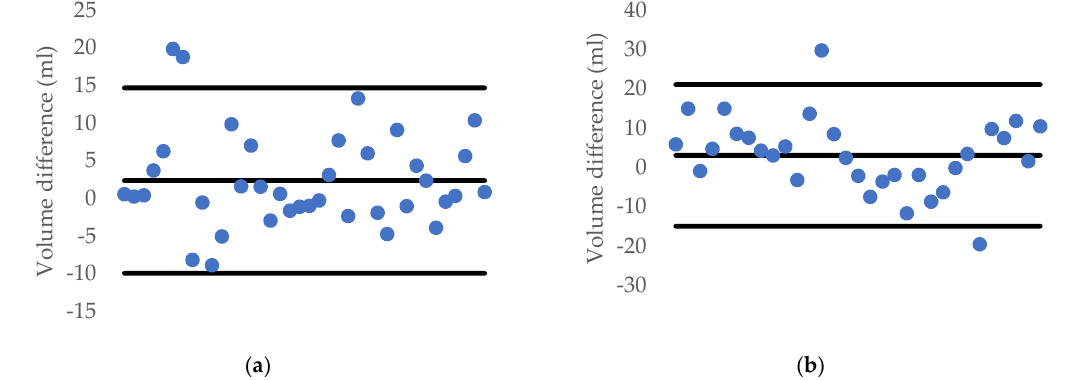
Figure 23. 1.96- σ plot for the volume di ff erence between water displacement and the ANN method: ( a ) carrot and ( b ) cucumber.